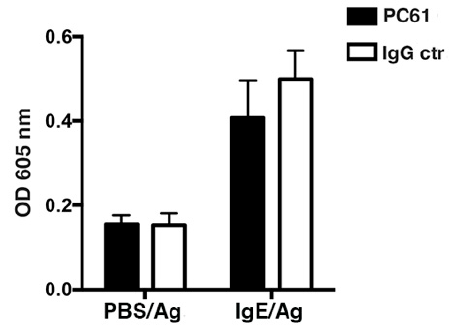
Figure 5. Tregs functional depletion does not affect the acute PCA response RMB mice (n = 6) were treated with rat anti-CD25 (PC61) or irrelevant IgG (IgG ctr) Ab (0.2 mg, ip) to deplete Tregs or not at day 0, before passive sensitization by subcutaneous (i.d.) ear injections at day 2 with anti-DNP IgE (IgE/Ag) or control PBS (PBS/Ag). At day 4, all mice were challenged i.v. with Ag (DNP-HSA 150 µ g) in 1% Evans blue (final volume 150 µ L) and were then sacrificed 30 min later to determine Evans blue extravasation. Quantification of Evans blue extracted from ears of mice (n = 6) in corresponding experiments is shown. No significant differences between the PC61-treated and IgG control-treated mice were noticed for ears sensitized with IgE (IgE/Ag) or with PBS (PBS/Ag) (unpaired t -test between groups).